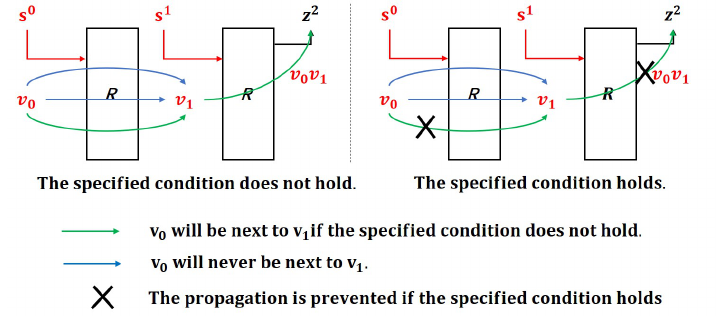
Figure 4: Illustration of TYPE-I conditional cube